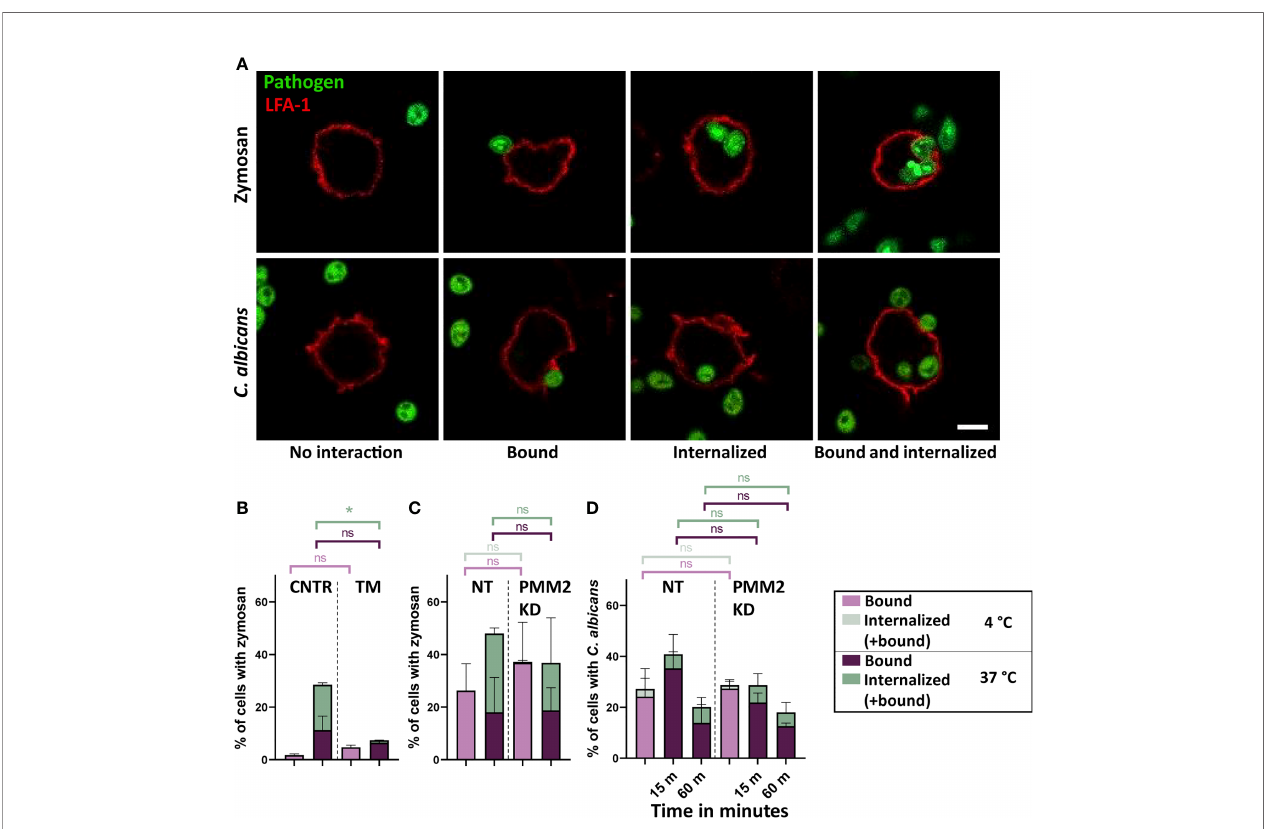
FIGURE 5 | Phagocytosis in glycosylation impaired THP-1 cells (A) Confocal microscopy images of THP-1 cell interactions with zymosan and C. albicans . The cell membrane is labelled by LFA-1 staining. Scale bar = 5 µm. (B) Binding and uptake of zymosan particles by control (CNTR, n = 2) and tunicamycin (TM, n = 2) treated THP-1 cells after 90 m of coincubation at 4°C and at 37°C. Cells were treated with 10 ng/mL tunicamycin for 4 days (C) Binding and uptake of zymosan particles by cells expressing non-targeting (NT, n = 2) or PMM2-targeting (PMM2 KD, n = 2) shRNAs after 90 m of coincubation at 4°C and at 37°C. (D) Binding and uptake of C . albicans by NT (n = 2) and PMM2 KD (n = 3) THP-1 cells after 15 or 60 m coincubation at 37°C. Negative control samples were incubated for 60 m at 4°C. Signi fi cance was calculated by One-way ANOVA and multiple comparisons. Mean ± S.D., ns = non-signi fi cant, * ≤ p-value